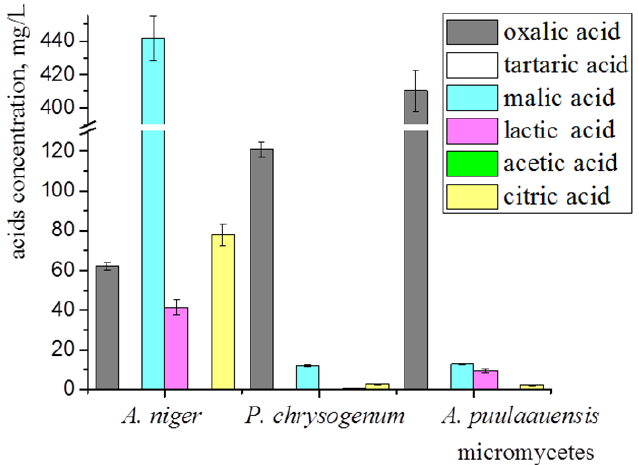
Figure 5. Organic acids synthesized by micromycetes growing on Czapek-Dox medium at 21st day of cultivation. Average data of three independent experiments with standard deviation are pre- sented.